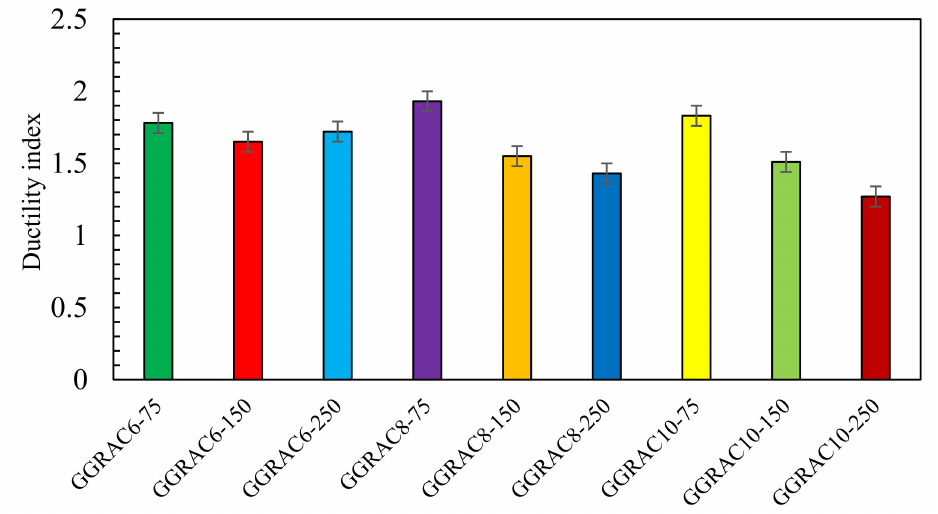
Figure 6. Ductility indices for various GGRAC compressive